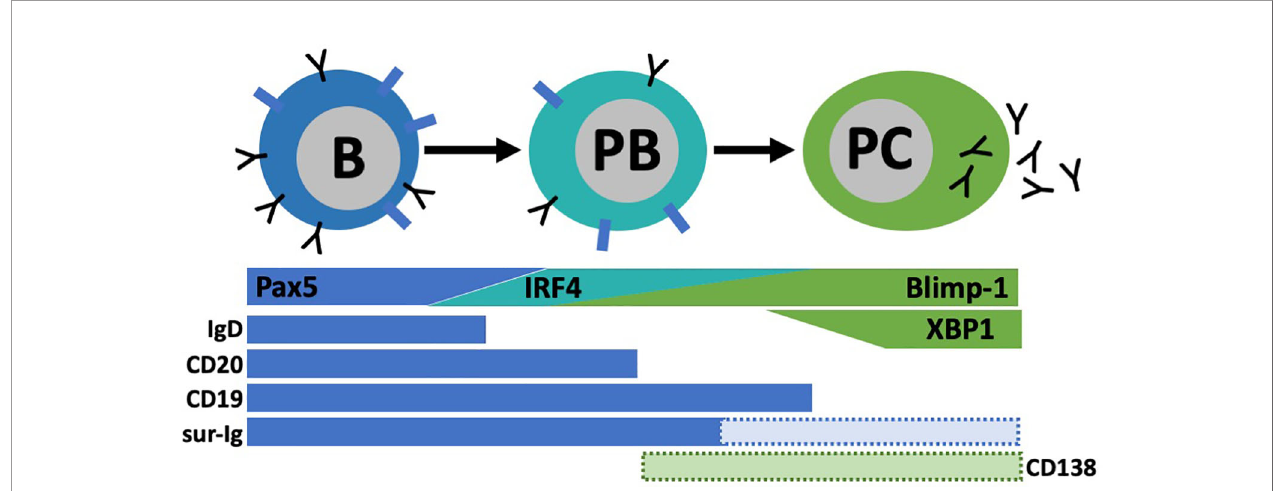
FIGURE 5 | Plasmablast (PB)/pIasma cell (PC) differentiation. B cells are characterized by their high expression of transcription factor Pax5 and surface markers lgD, CD20, CD19, and surface lg (sur-lg). When B cells differentiate into PC, they transverse through a PB stage known for its high proliferative capacity. As PC maturation continues, Pax5 expression is lost and other transcriptional programs (IRF4, Blimp-I, XBPI) are upregulated. Concurrently, most B cell surface proteins are lost. Some subsets of PB and PC have expression of CD138 among other markers, but not all express